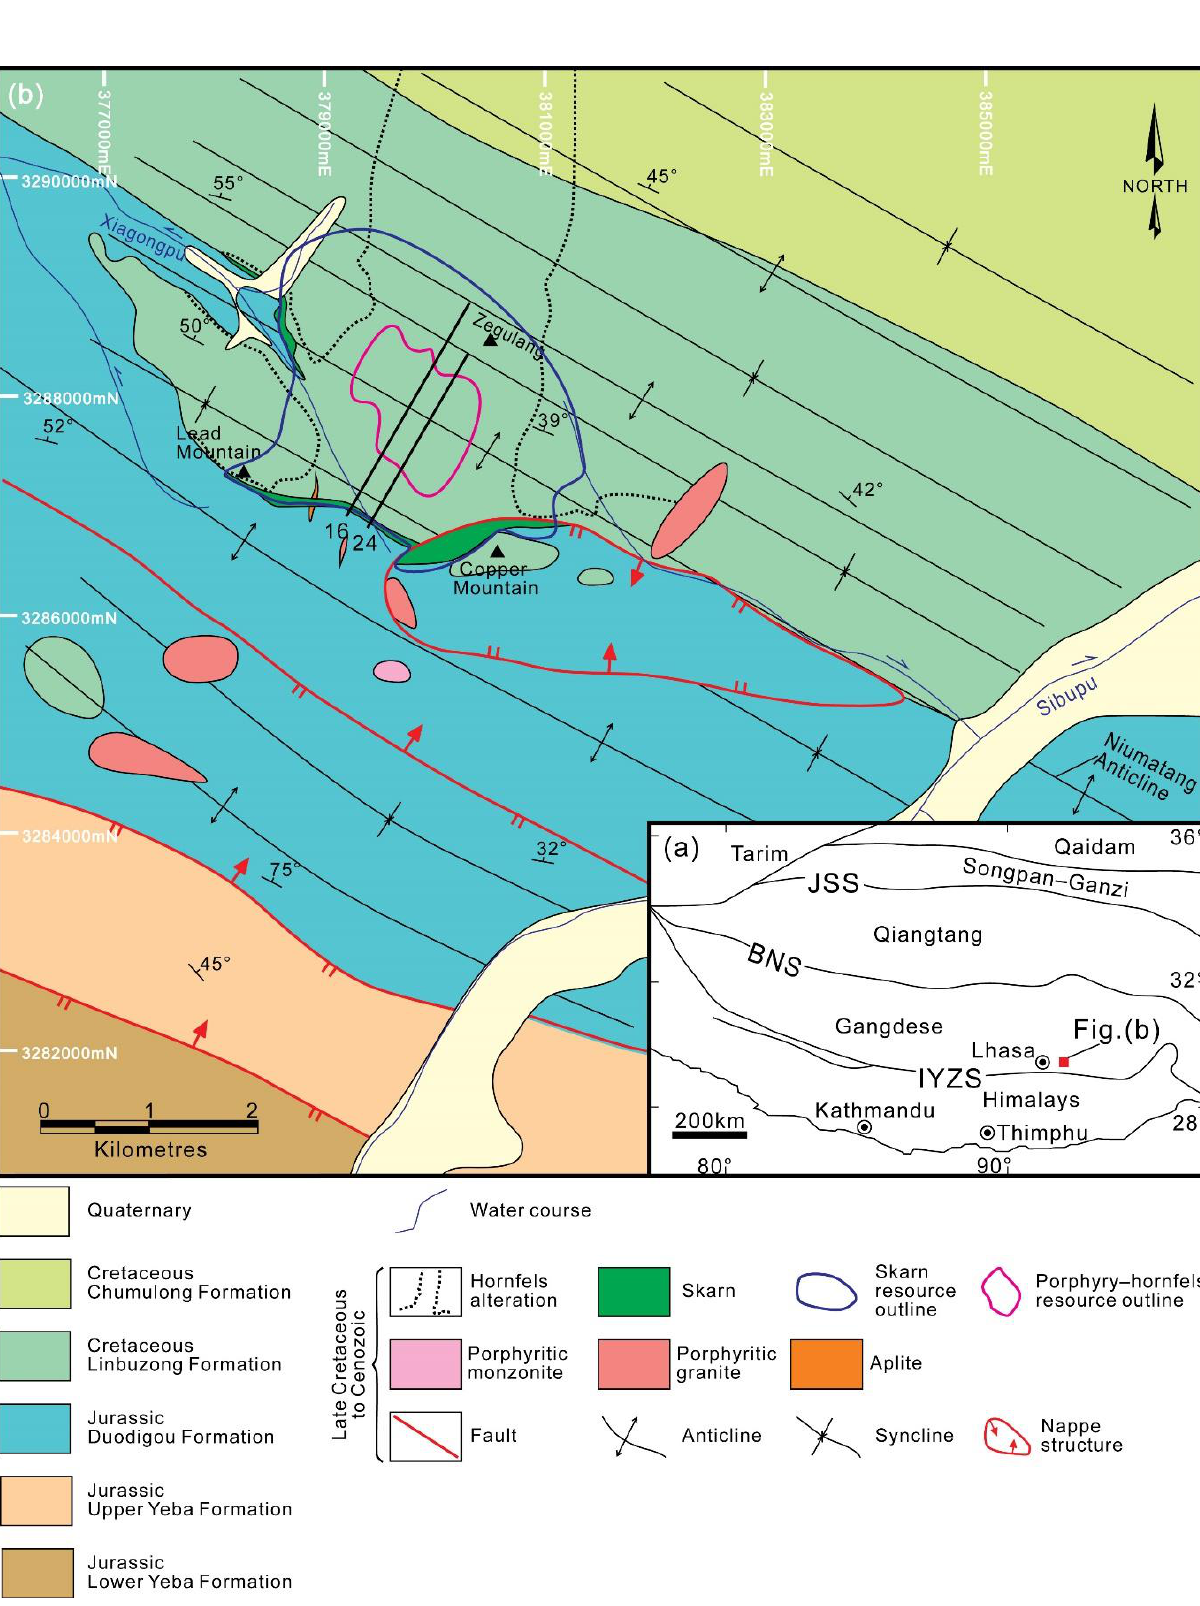
Figure 1. Maps: ( a ) Tectonic sketch map showing the location of the study area [37]; and ( b ) generalized geological map of the Jiama ore district (modified from [10]). Abbreviations: JSS = Jinsha suture; BNS = Bangong–Nujiang suture; IYZS = Indus–Yarlung Zangbo suture.